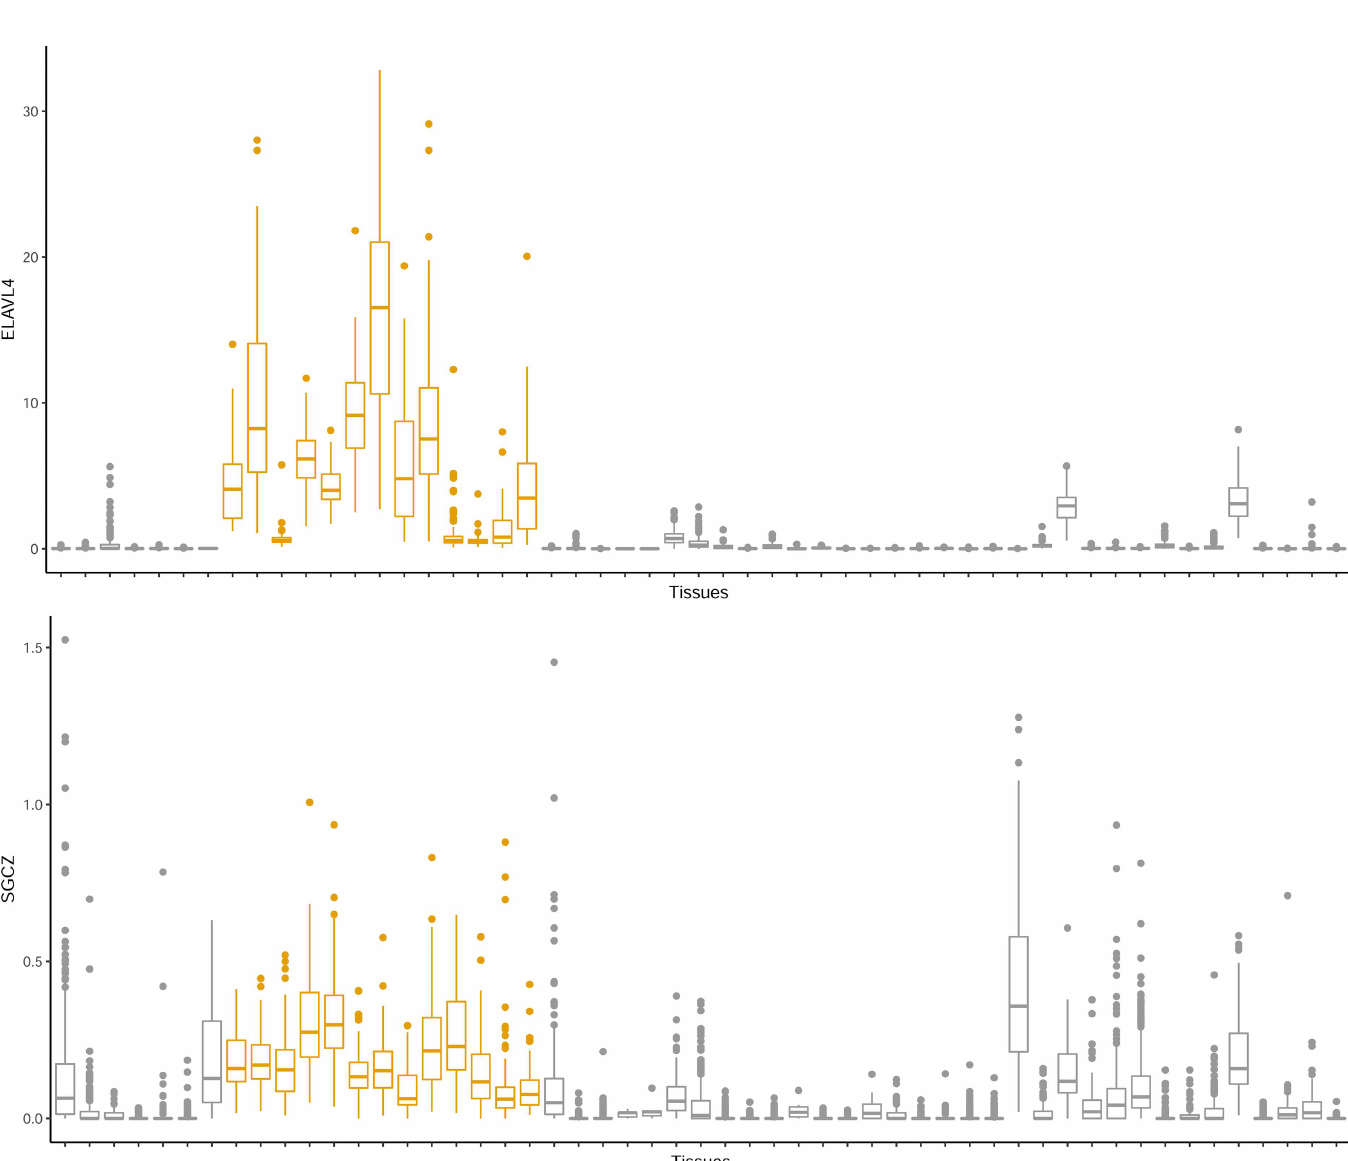
S1 Table. 241 selected SNPs and the AIC values of different DAGs and minimum AIC val- ues of different categories.